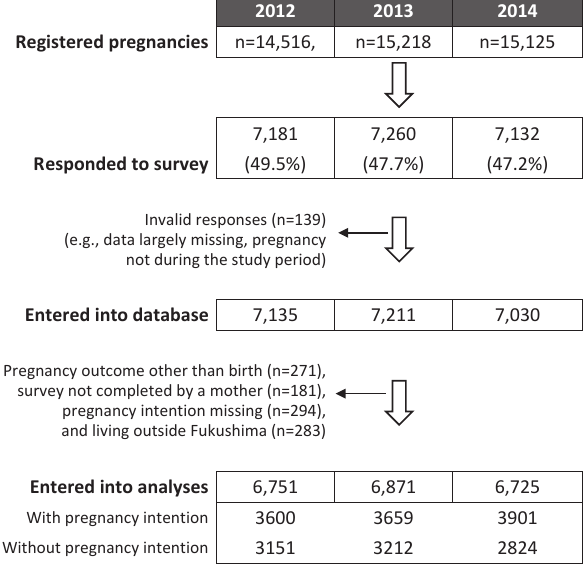
Figure 1. Flow diagram of